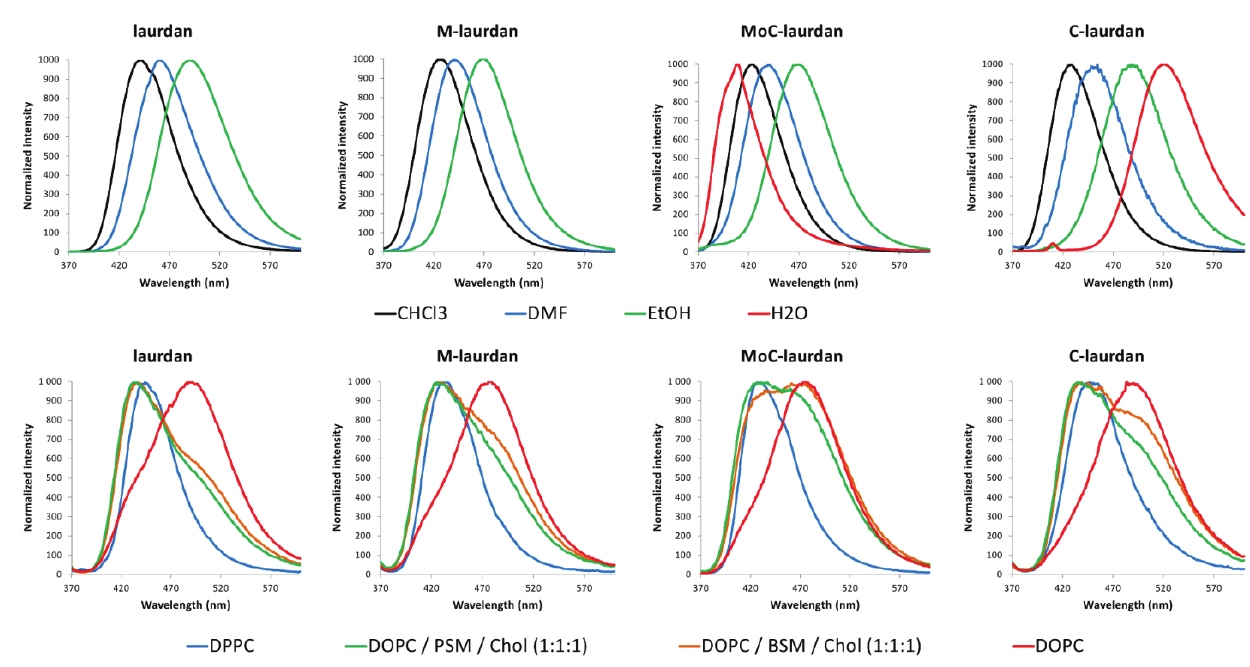
Supplemental Figure S5. Normalized emission spectra of dyes in solvents and lipid vesicles for So, Lo and Ld phases. Upper panels show normalized emission spectra of laurdan, M-laurdan, MoC-laurdan and C-laurdan in chloroform, Dimethylformamide, ethanol and water (when detectable, i.e. only for Moc-laurdan and C-laurdan). The blue shift seen for the emission spectrum for MoC-laurdan in water is attributed to the fluorescence of non hydrated aggregates, whereas C-laurdan which is highly soluble in water undergoes the expected red shift. Lower panels show emission spectra of laurdan, M-laurdan, MoC-laurdan and C-laurdan in LUVs made of DPPC (So, blue), DOPC/PSM/chol 1:1:1 (Lo, green), DOPC/BSM/chol 1:1:1 (Lo, orange) and DOPC (Ld, red) at 25°C.